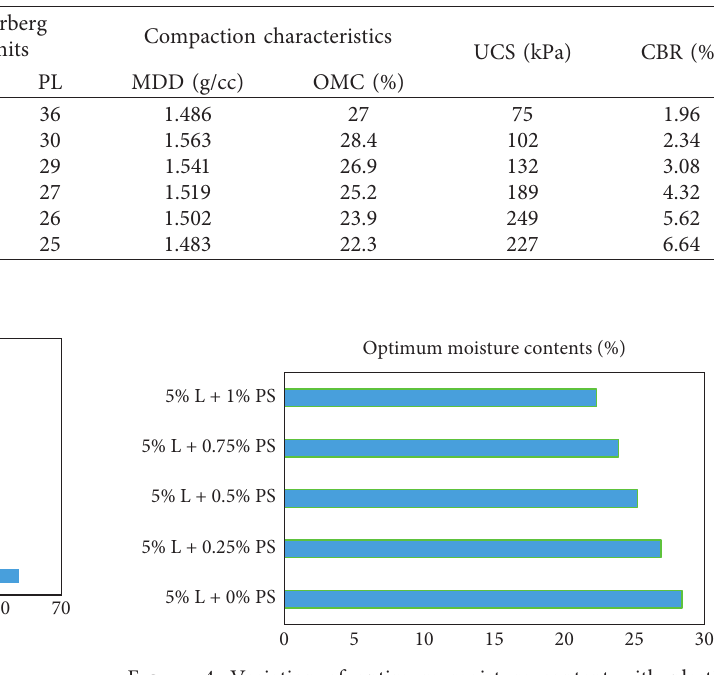
Figure 2: Variation of liquid limit and plastic limit with per- centages of plastic strips.